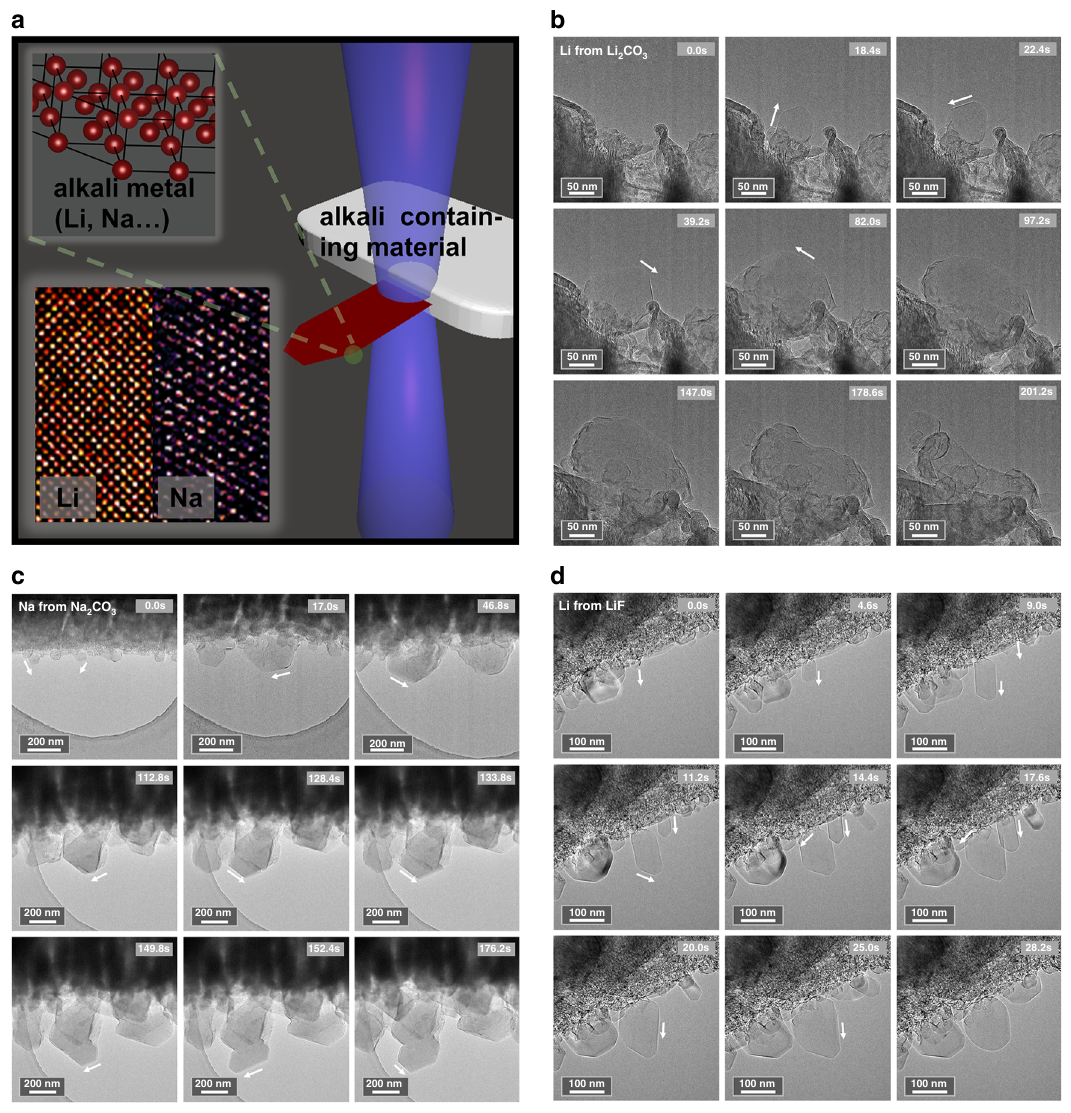
Fig. 1 In situ formation and growth of alkali metal particles. a Schematic of the experimental process. An alkali (Li, Na) metal particle formed from their corresponding alkali containing materials under beam irradiation. The inset shows the b.c.c. structure of alkali metals. Atomic resolution images of both lithium and sodium metals are shown at room temperature condition. b In situ growth of Li particles from lithium carbonate. c In situ growth of Na particles from sodium carbonate. d In situ growth of Li particles from lithium fl